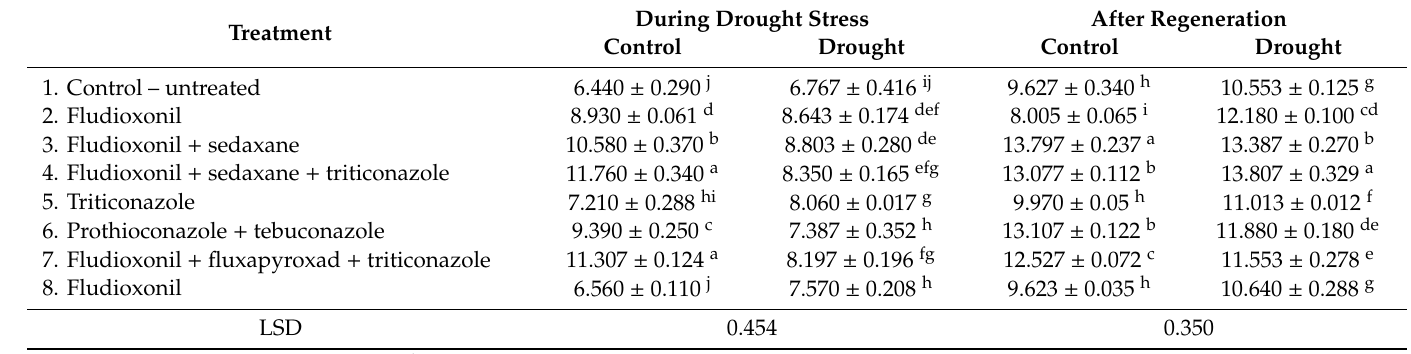
Table 3. The influence of the seed treatment and drought stress on photosynthesis rate (CO 2 assimilation)—A (mmol × m − 2 × s − 1 ) during drought stress and after regeneration.